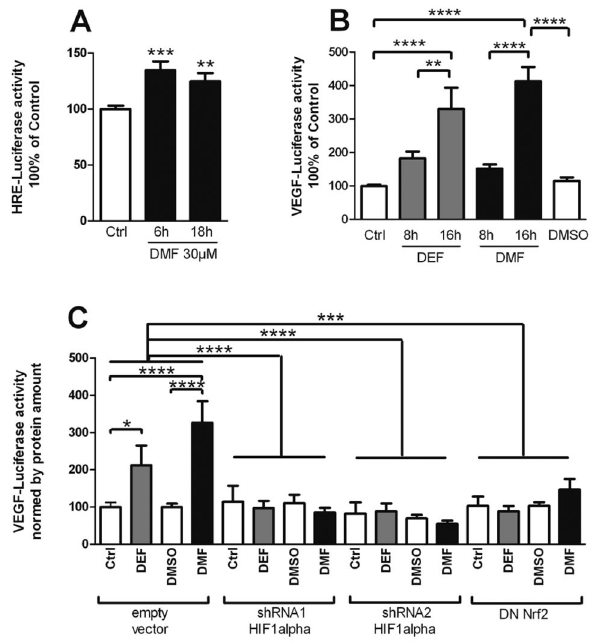
Figure 4. Reporter assay evidence of HIF-1α involvement in VEGF release. Wild type astrocytes were transfected with a HRE-Luciferase reporter plasmid (A), with a VEGF-Luciferase reporter plasmid (B), or were cotransfected with both VEGF- Luciferase plasmid and either an empty vector or a vector encoding a shRNA targeting HIF-1α (two different used, shRNA1 or 2), or an expression vector encoding a dominant negative Nrf2 isoform (C). After 24h cells were treated with 30µM DEF, 30µm DMF or 0,05% DMSO for 6h (A), for 8h (B) or 18h (A-C). Luciferase activity was then measured in cell extract by luminescence. *p<0,05 - ****p<0,0001; significantly different from corresponding control. Values are mean +/- SEM of n=3 independent